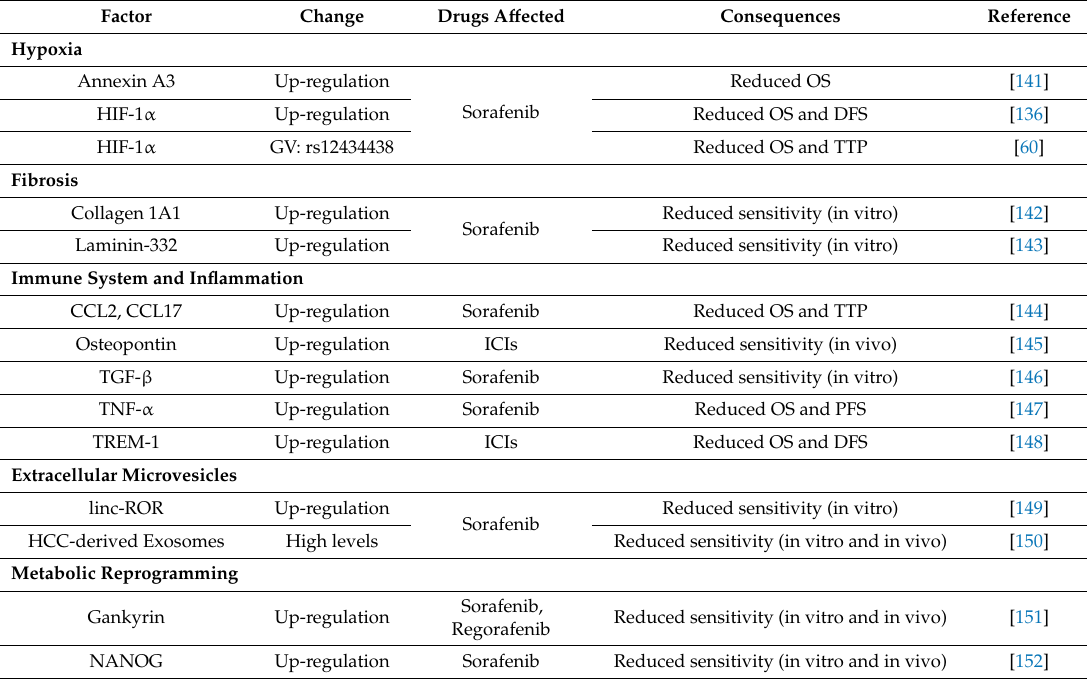
Table 4. Mechanisms of chemoresistance type 6 (MOC-6) to drugs clinically used in